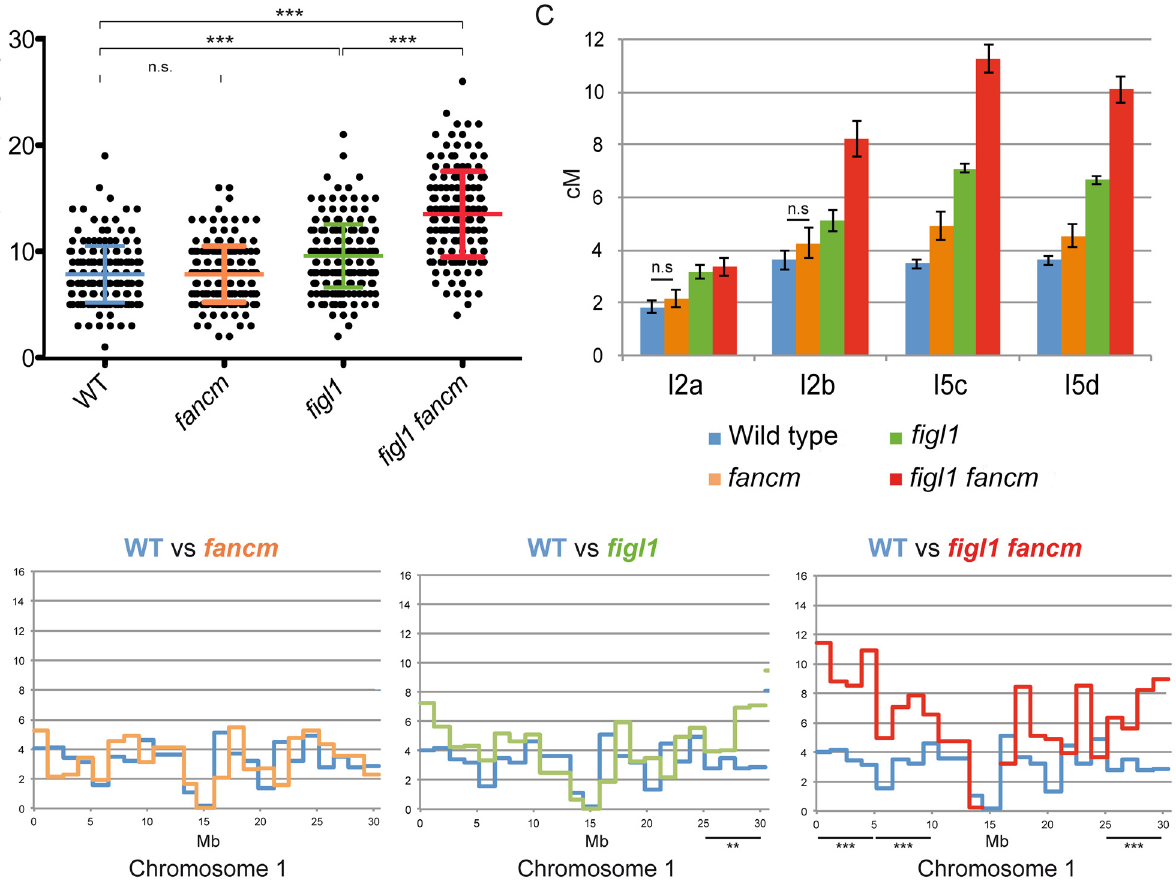
Fig 3. The effect of figl1 and fancm on recombination in hybrids. A: CO count in each F2 progeny obtained from parent plants from Columbia-0/ Landsberg (Col/Ler) F1 hybrids. Means and SD are indicated. n.s.: not significant; *** indicates significant difference, T-Test p < 0,001. B: Recombination frequency (in cM/Mb) along chromosome I compared to wild type for each genotype. Difference in recombination frequency was tested along the genome on ~5Mb intervals (see methods). See also S5A Fig. C: Genetic distances (in cM) measured from tetrad analysis in a series of intervals, in Col/Ler F1 hybrids. All genotypes on all intervals are significantly different from wild type (Z-test, p < 0.03), except when noted (n.s.: not significant).